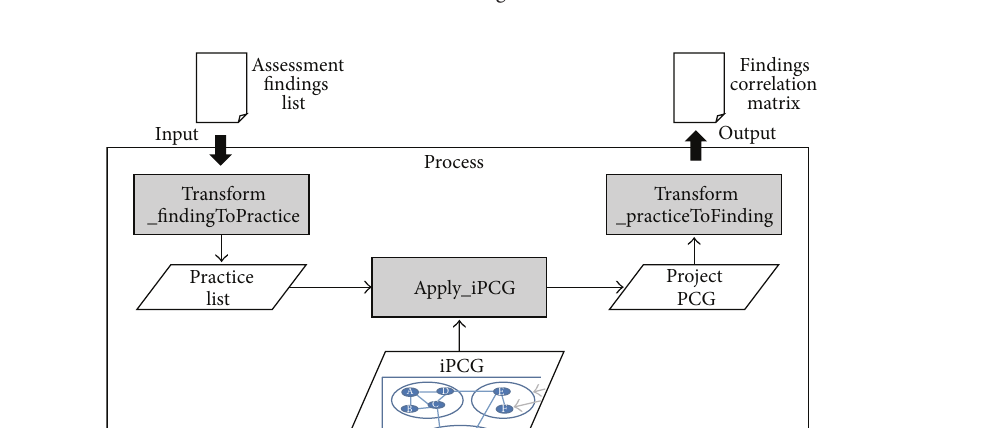
Figure 7: Building an iPCG.